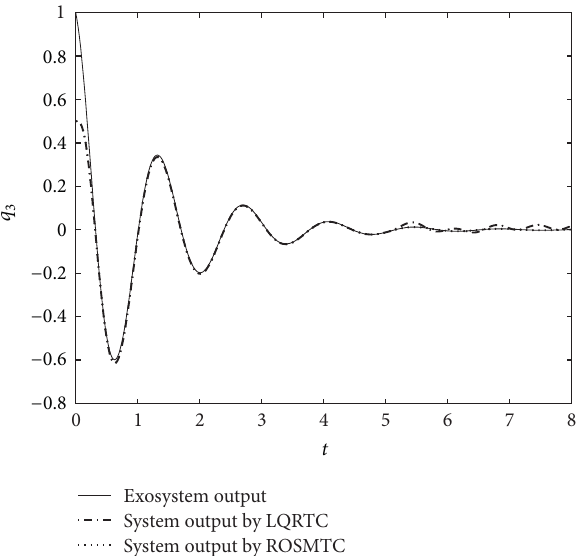
Figure 8: The tracking response curve of the position 𝑞 2 for link 2.